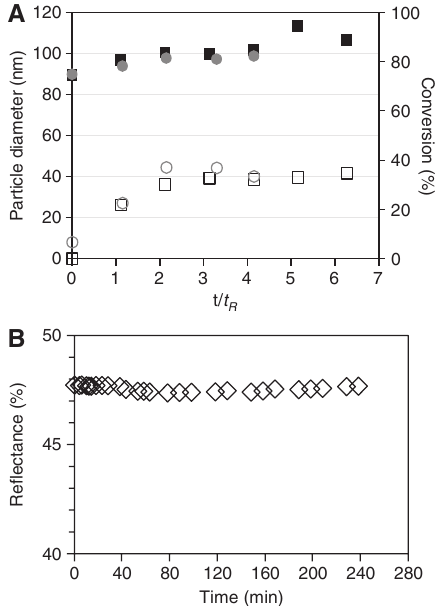
Figure 3 (A) Evolution of conversion (open symbol) and particle size (full symbols) during the MMA/BA/AA (49.5:49.5:1 wt%) mini- emulsion